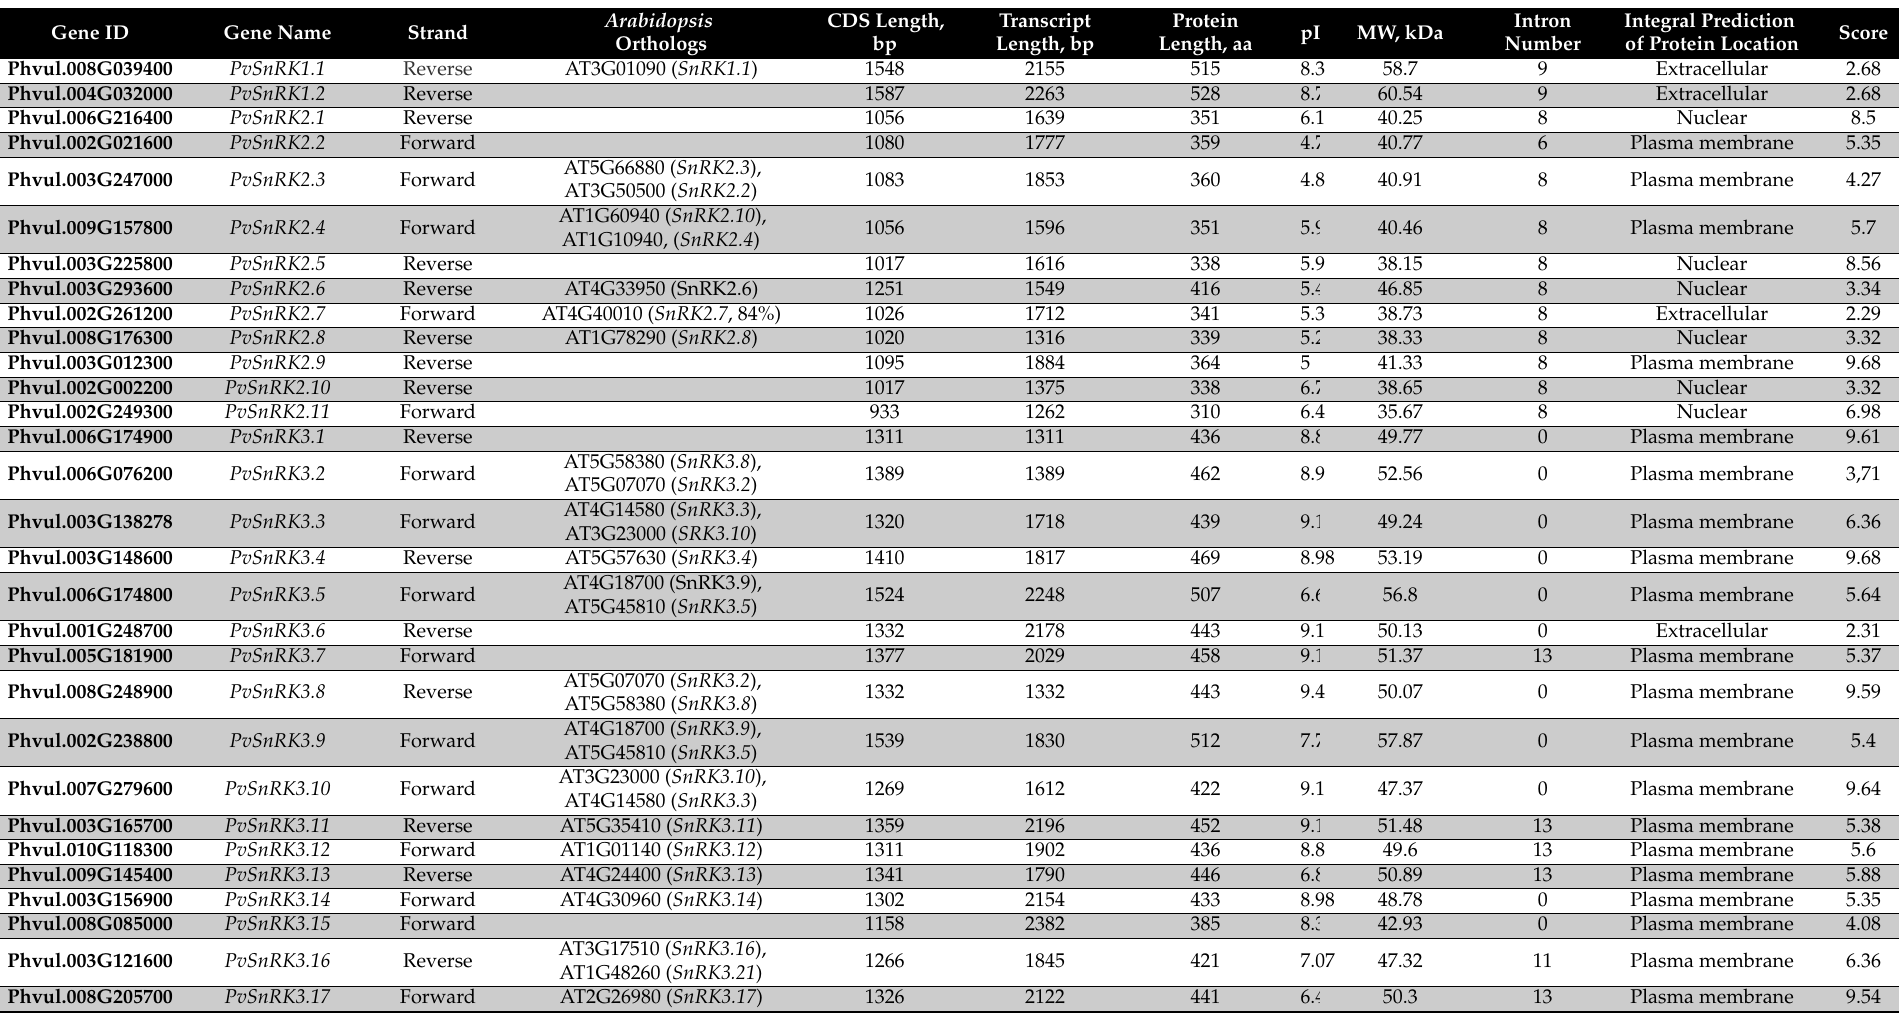
Table 1. Gene information of Phaseolus vulgaris SnRK gene family. *Phytozome gene ID; bp—base pairs; CDS—coding sequence; aa—amino acids; pI—isoelectric point; MW—molecular weight;